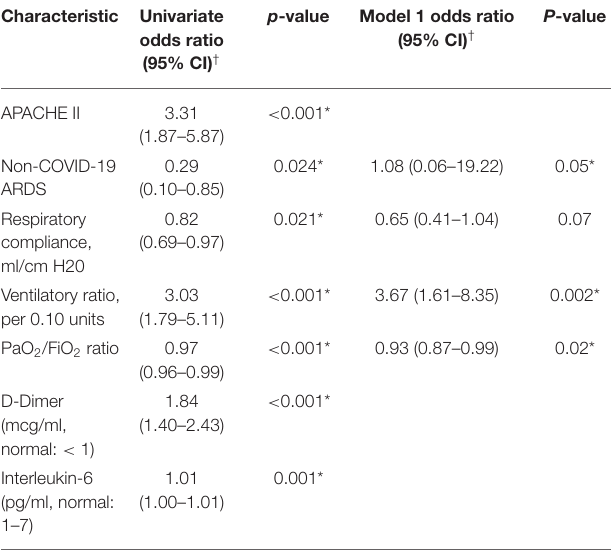
TABLE 6 | Univariate and multivariate logistic regression analysis of predictors of 60-day mortality in eighty-five COVID-19 and non-COVID-19 patients with acute respiratory distress